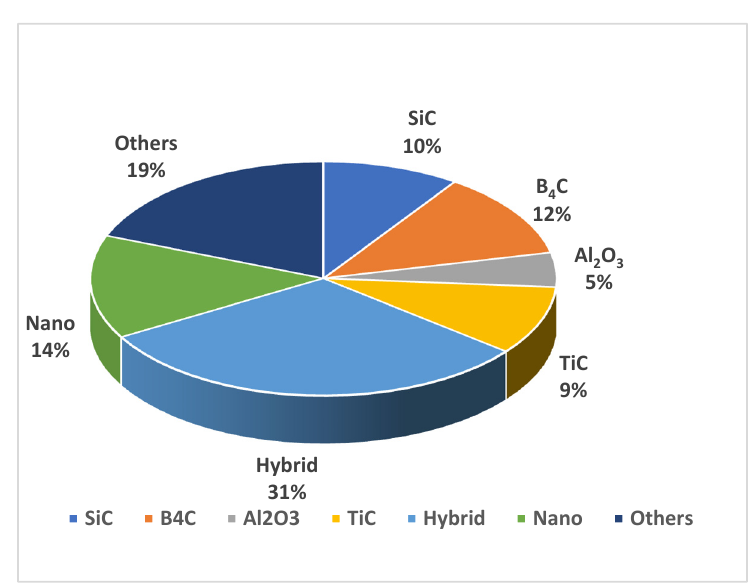
Figure 5. Percentage of research studies related to reinforcement types used in AA 6061 compo- sites.